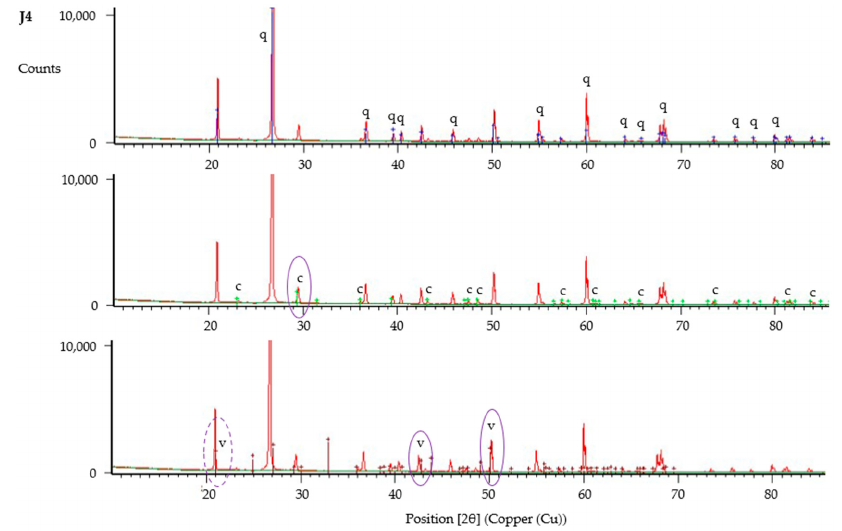
Figure 17. XRD analysis of sample from column J4, showing identified peaks of quartz (q), calcite (c) and vaterite (v). The peak at 21 [°2 θ ] is identified as vaterite based on results for J1 and C1, however results for J4 alone suggest this could be also be quartz.